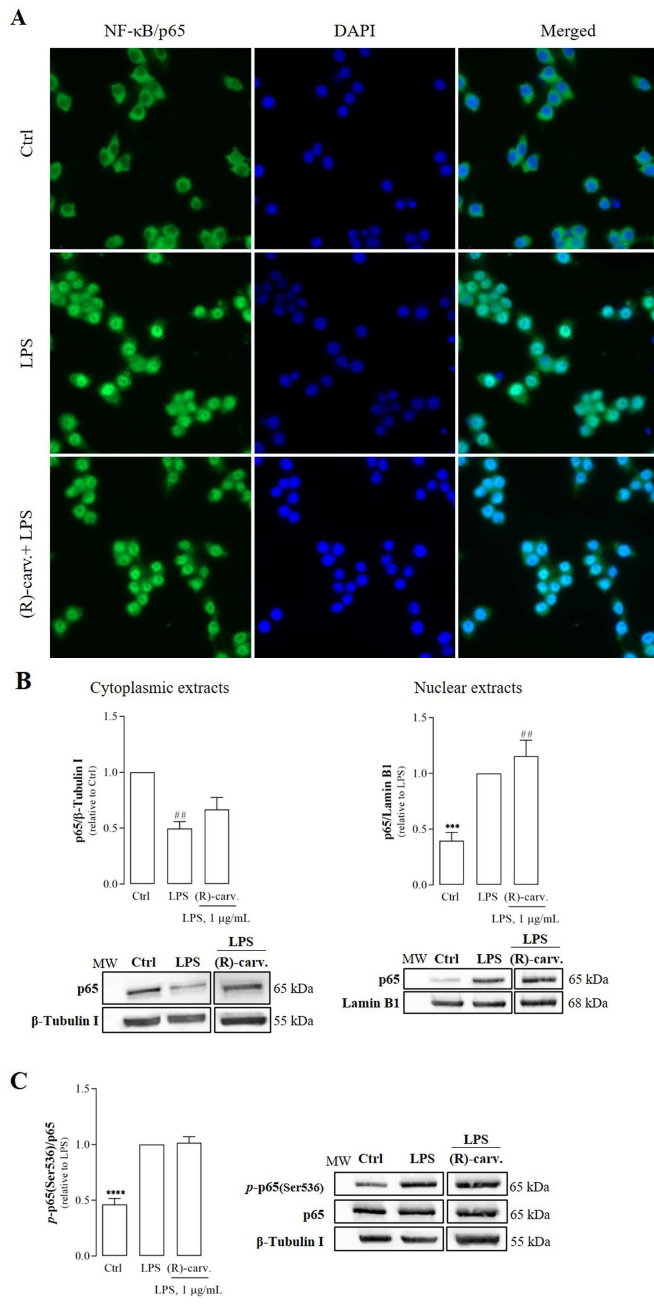
Figure 4. NF- κB/p65 nuclear translocation ( A , B ) and phosphorylation at Ser536 ( C ) are not inhibited by (R)-(-)-carvone. ( A ) Macrophages were pre-treated with the vehicle (0.1% DMSO) or 665 µM (R)- (-)-carvone for 1 h, and then with 1 µg/mL LPS for 20 min. Control cells (Ctrl) were treated with the vehicle (0.1% DMSO) alone. Immunofluorescence staining of NF- κB/p65 (green) and the nuclei (blue) were performed as described in Materials and Methods . Representative images of each condition are shown. Scale bar: 20 µm. ( B , C ) Macrophages were treated with 1 µg/mL LPS for 1 h ( B ) or 15 min ( C ), following pre-treatment with the vehicle (0.1% DMSO) or 665 µM (R)-(-)-carvone for 1 h. Total ( B ) and Ser536-phosphorylated ( C ) RelA/p65 levels were evaluated by Western blot in cyto- plasmic and nuclear extracts ( B ) and in total cell extracts ( C ). Control cells (Ctrl) were treated with the vehicle alone (0.1% DMSO). Each column represents the mean ± SEM of four (cytoplasmic levels in panel ( B ) and panel ( C ) or six (nuclear levels in panel B ) independent experiments. Representative images are shown. The corresponding images of the full-length blots are shown in Supplementary Figure S1. *** p < 0.001 and **** p < 0.0001 relative to LPS-treated cells. ## p < 0.01 relative to the Ctrl. MW: molecular weight marker. 3.3. (R)-(-)-Carvone Inhibits I κ B- α Resynthesis Our previous results demonstrated that (R)-(-)-carvone decreased the expression of two NF- κ B target genes, NOS2 and IL- 1β [10]. However, the results above showed that this compound did not interfere with the canonical NF- κ B activation pathway. Thus, to further confirm those previous results, the expression of another NF- κ B-dependent gene, I κ B- α [19] , was evaluated. For this, we first performed time course experiments to deter- mine the time point after the addition of the inflammatory stimulus, at which the